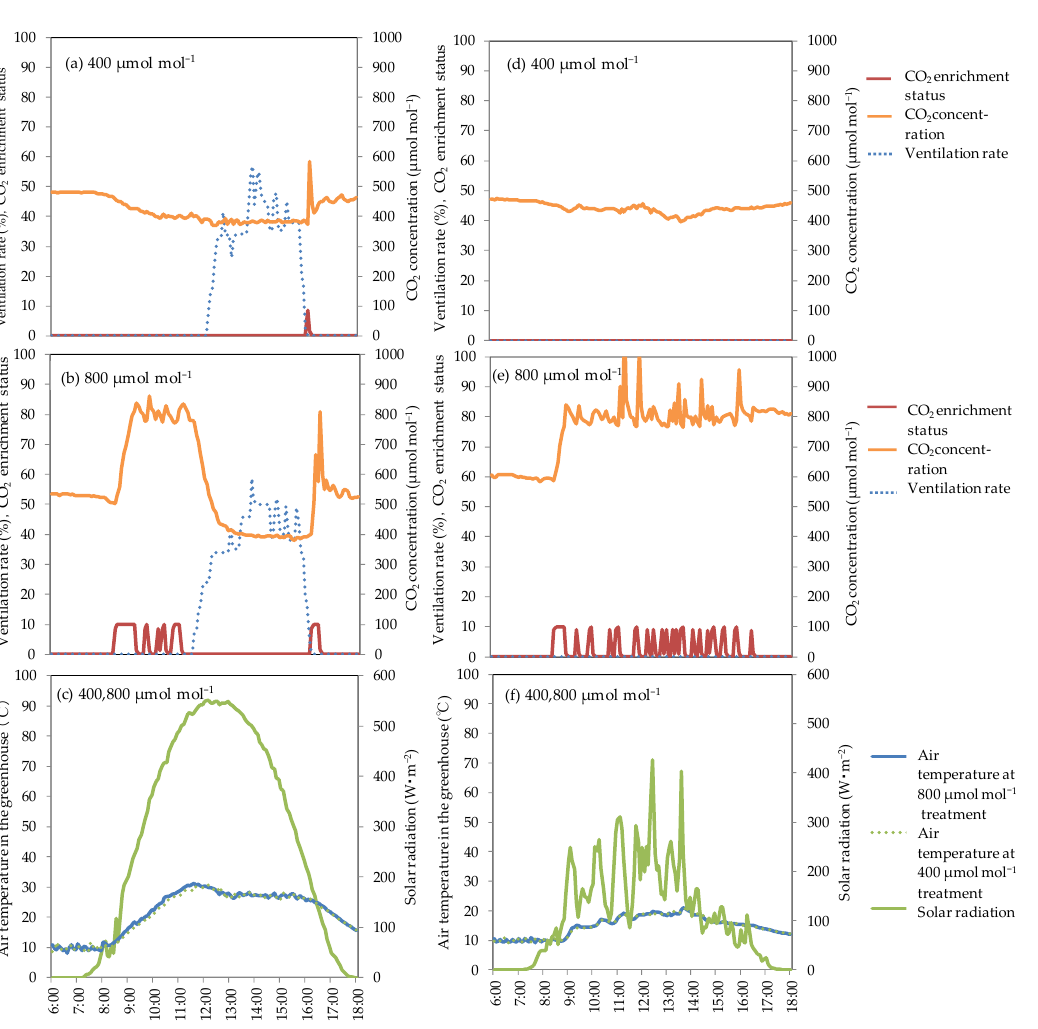
Figure 3. The change in ventilation rate, CO 2 enrichment status, CO 2 concentration, and air tempera- ture in the greenhouse, solar radiation in the sunny day ( a – c ) and cloudy day ( d – f ). The sunny day ( a – c ) is 28 January 2017, total solar radiation was 14.79 MJ m − 2 . The cloudy day ( d – f ) is 12 January 2017, total solar radiation was 5.40 MJ m − 2 . CO 2 enrichment status means ON: 10, OFF: 0. CO 2 concentration was controlled that 400 µ mol mol − 1 treatment was kept more than 400 µ mol mol − 1 in all day and 800 µ mol mol − 1 treatment was kept more than 800 µ mol mol − 1 and 400 µ mol mol − 1 during no ventilation and ventilation,